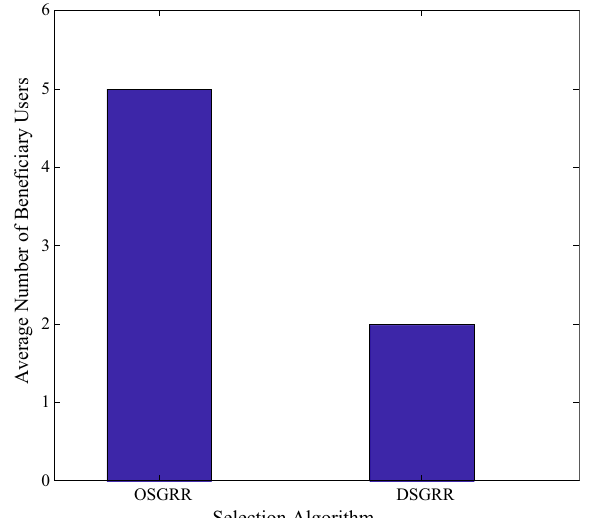
Fig. 12 An illustrative example of the average number of candidate beneficiary users of every sub‑grant